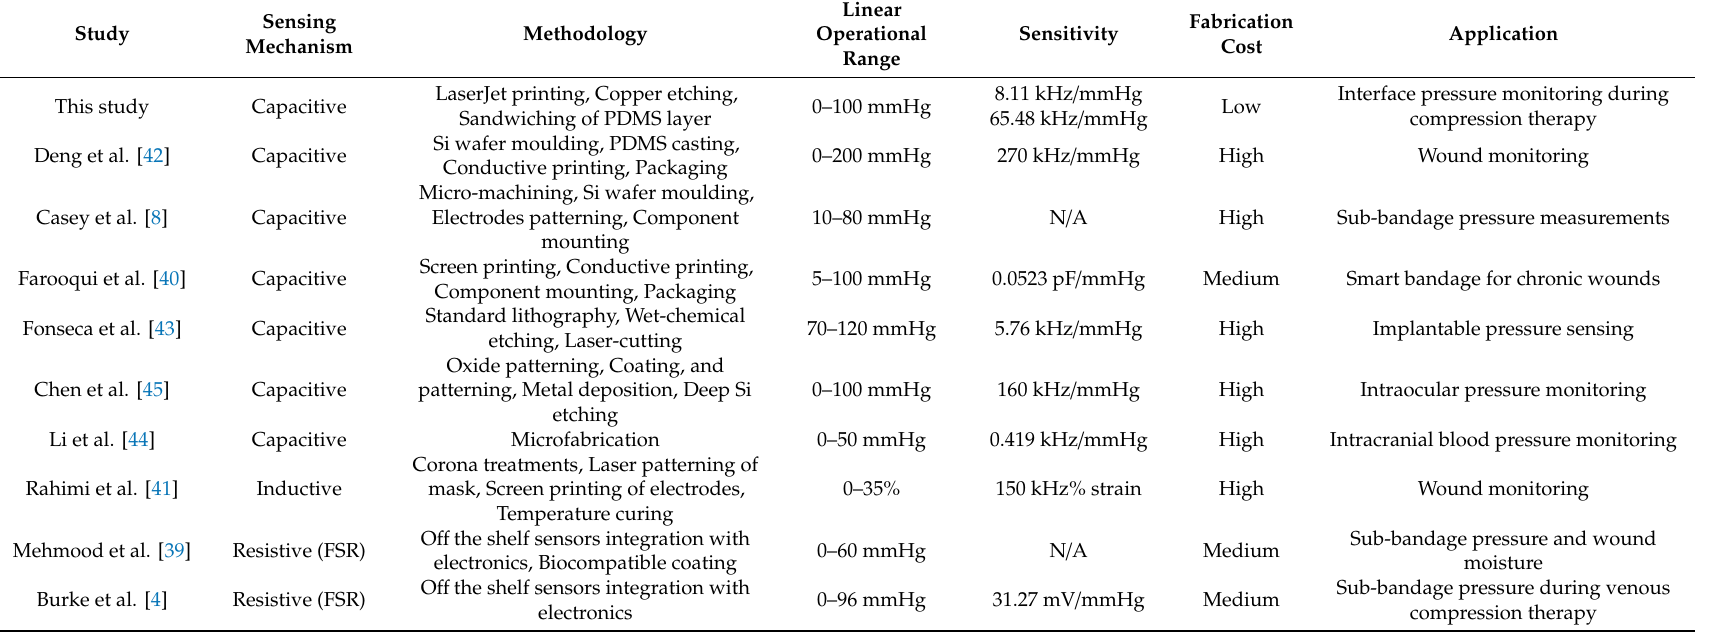
Table 5. Comparative analysis of this study with the